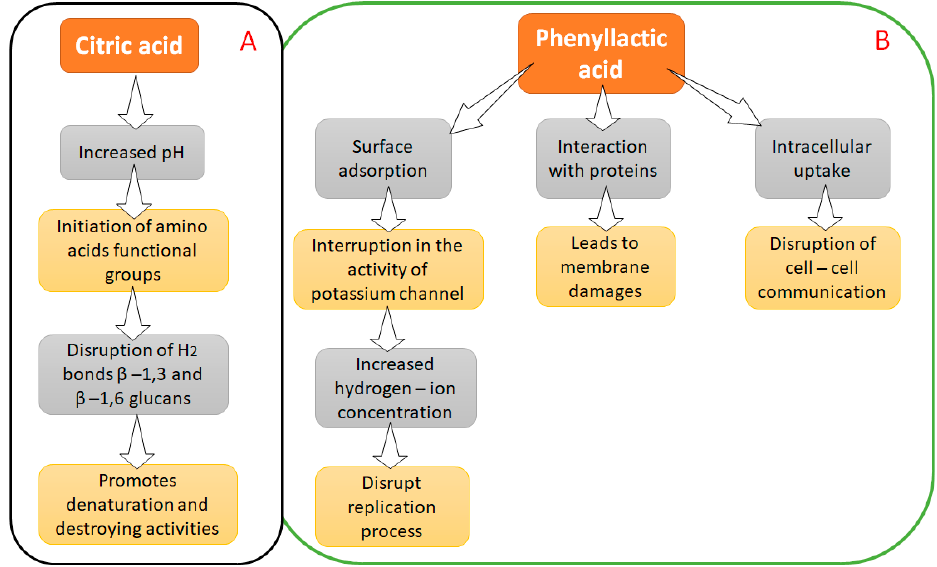
Figure 2. Mechanism of organic acids (( A ) for Citric acid; ( B ) Phenyllactic acid) as bio-preservatives.